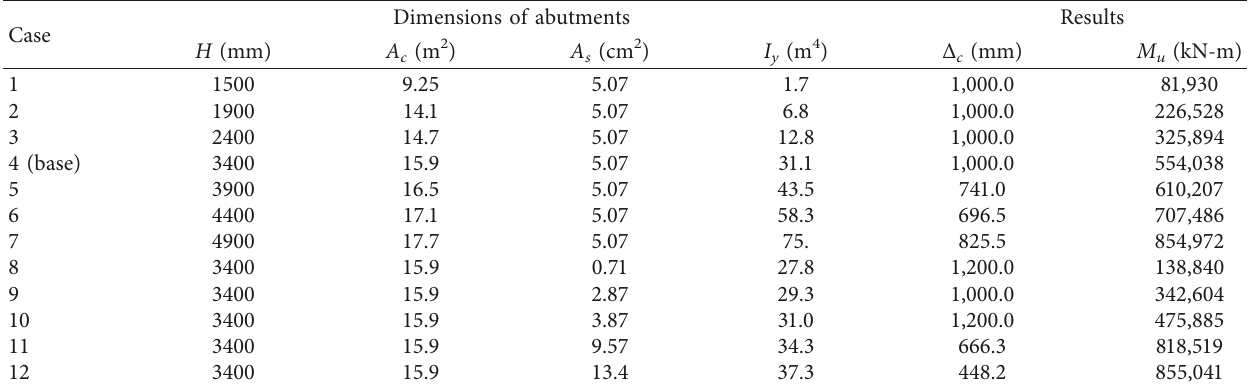
Table 4: Parametric analysis